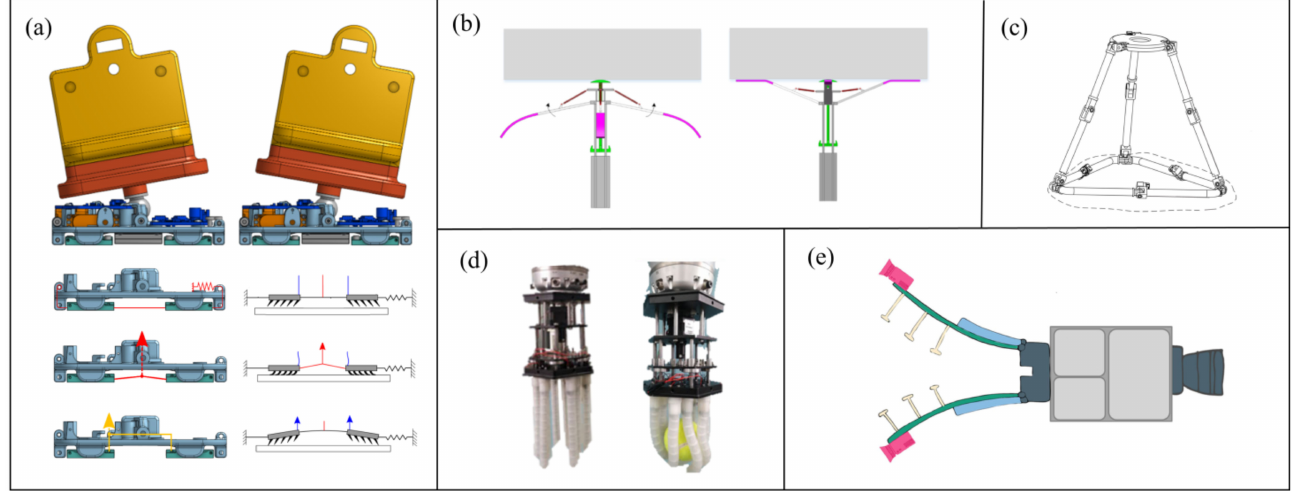
Figure 6. Reciprocally bonded/internally caged end-effector with parts: ( a ) gecko-like reciprocally bonded end-effector [154]; ( b ) bonding capture mechanism [155]; ( c ) multi-closed-loop flexible actuators [156]; ( d ) sea-anemone-like multi-flexible arm [157]; ( e ) flycatcher-like internally caged end-effector